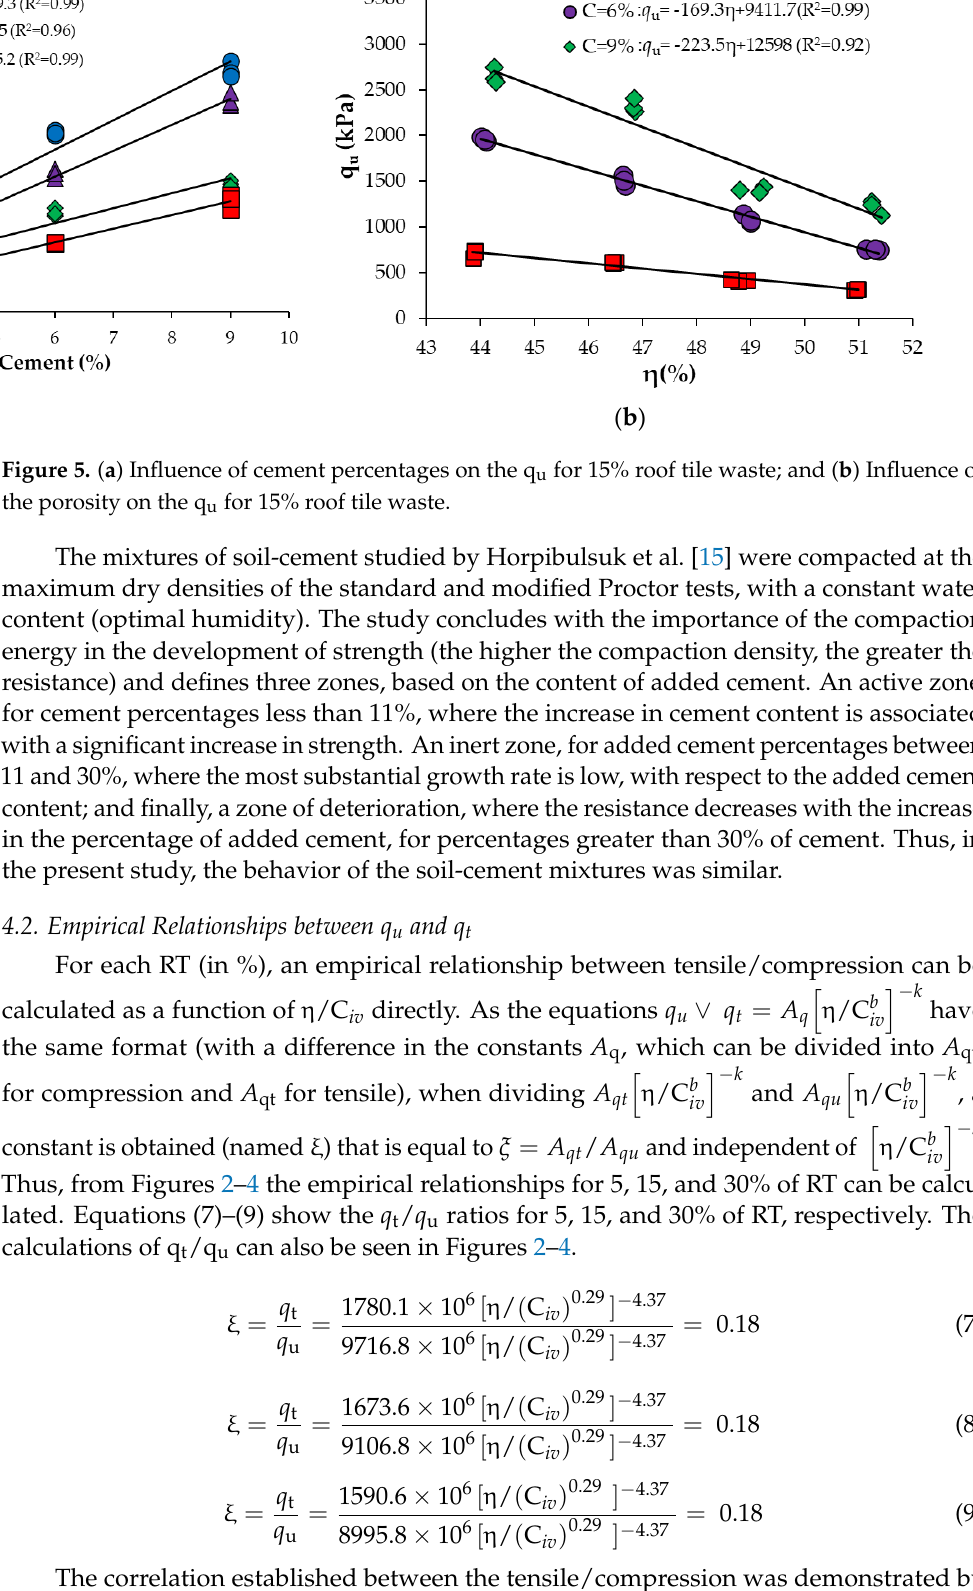
Figure 4 . Variation of q u and q t with the porosity/volumetric cement ratio (using the exponent b = 0.29) for 15% of roof tile waste.